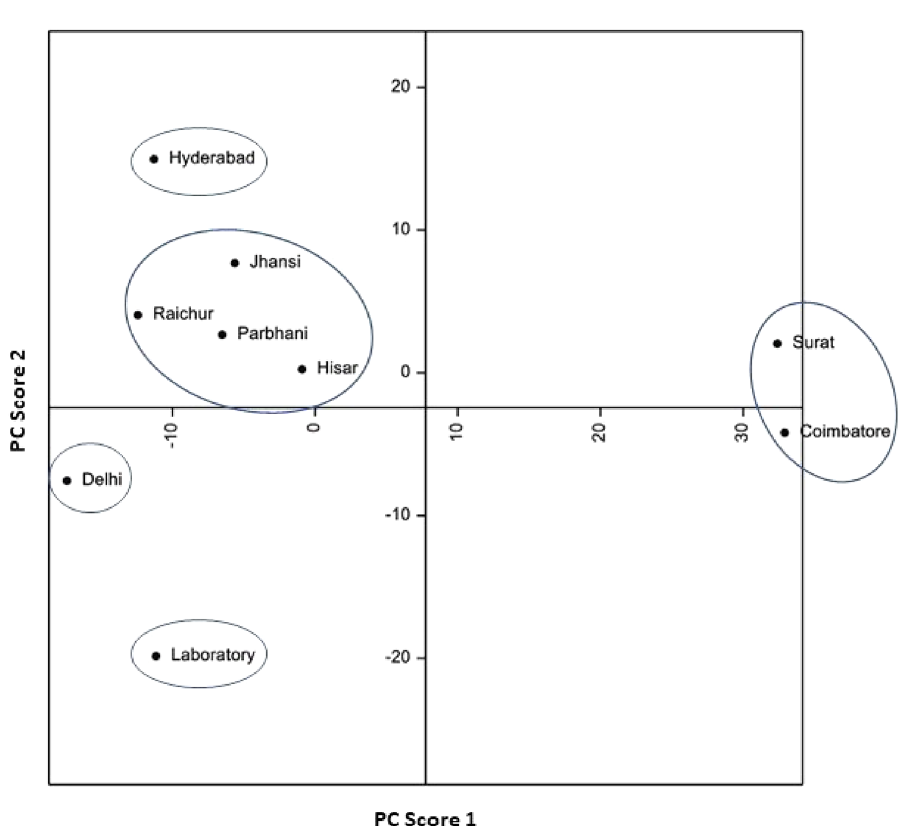
Figure 1. Diversity in different geographical C. partellus populations based on biological traits, and damage caused to sorghum and